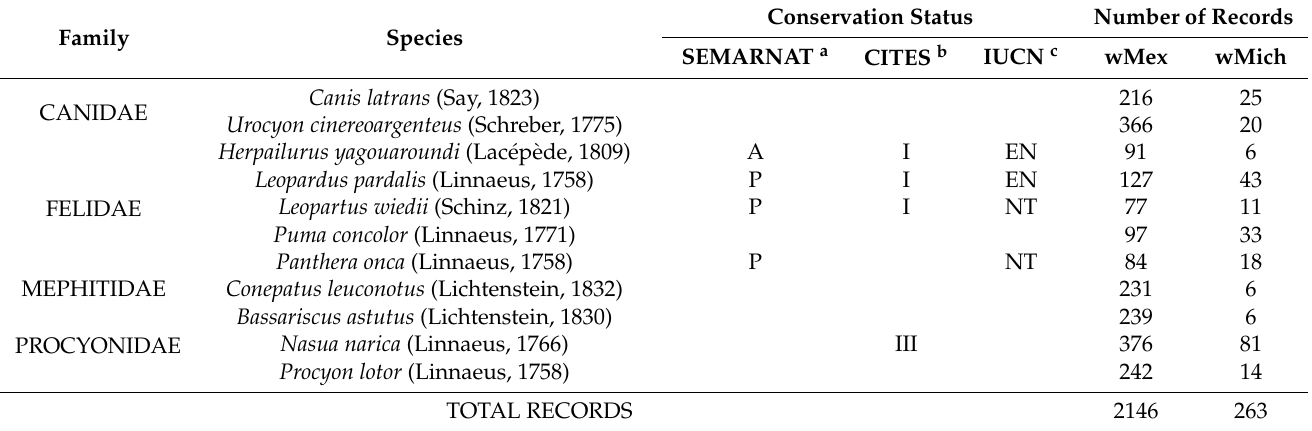
Table 1. Carnivore species, conservation status and record number by species in two databases, wMex (western M é xico) and wMich (western Michoac á n). Taxonomy according to Ram í rez-Pulido et al.